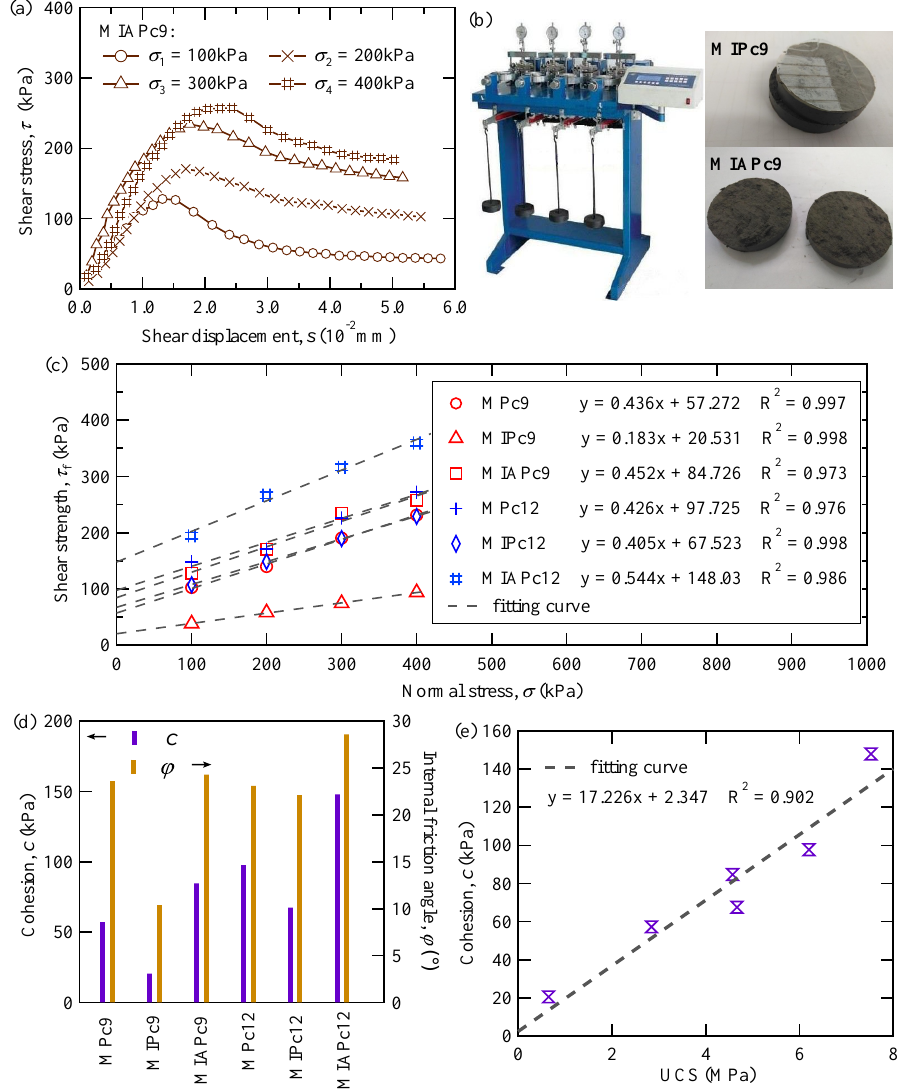
Figure 6. Results of DST: ( a ) Shear stress-displacement curves from DST of sample MIAPc9 ; ( b ) ZJ strain-controlled direct shear instrument and the failure modes of some samples after DST; ( c ) Fitting curves between shear strength and normal stress of different samples; ( d ) Cohesion and internal friction angle of different samples; ( e ) Relationship between cohesion and UCS for all